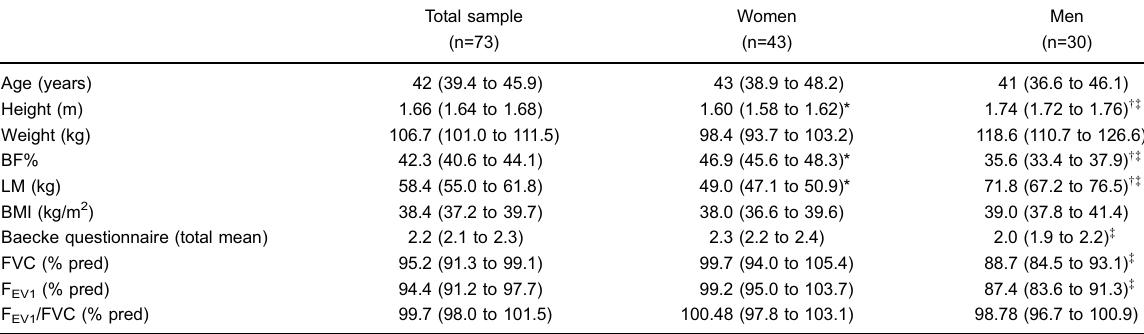
Table 1. Demographic, anthropometric, body composition, physical activity level, and lung function of the volunteers. Total sample